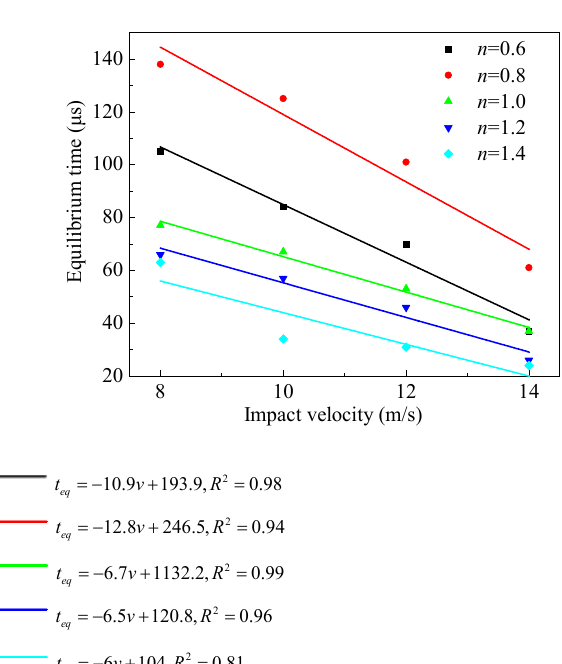
Figure 5. Duration of stress equilibrium.